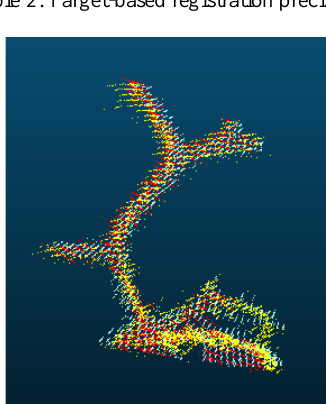
Figure 11. Target-based registration results from four range cameras from a single sampling